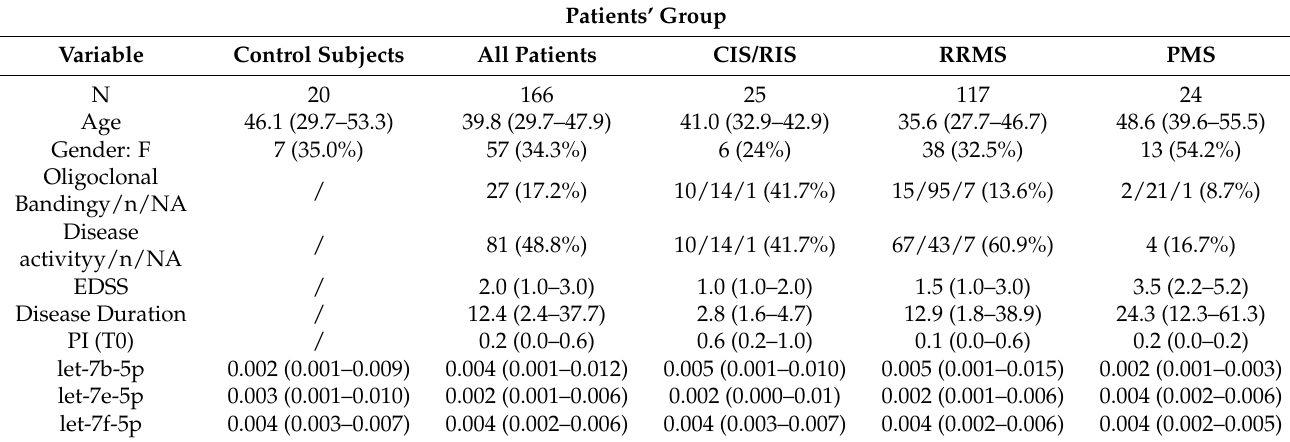
Table 1. Demographic and clinical features of the main cohort of patients with MS and control subjects. Patients’